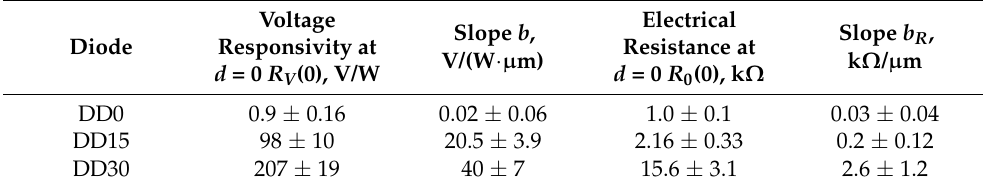
Table 2. Parameters of the linear dependence of voltage sensitivity and electrical resistance on diodes’ contact